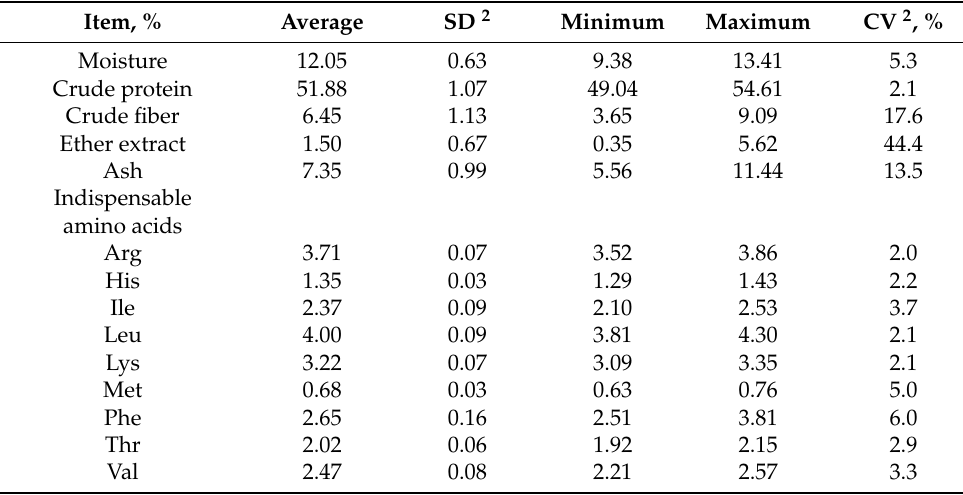
Table 1. Chemical composition of soybean meal, dry matter basis 1